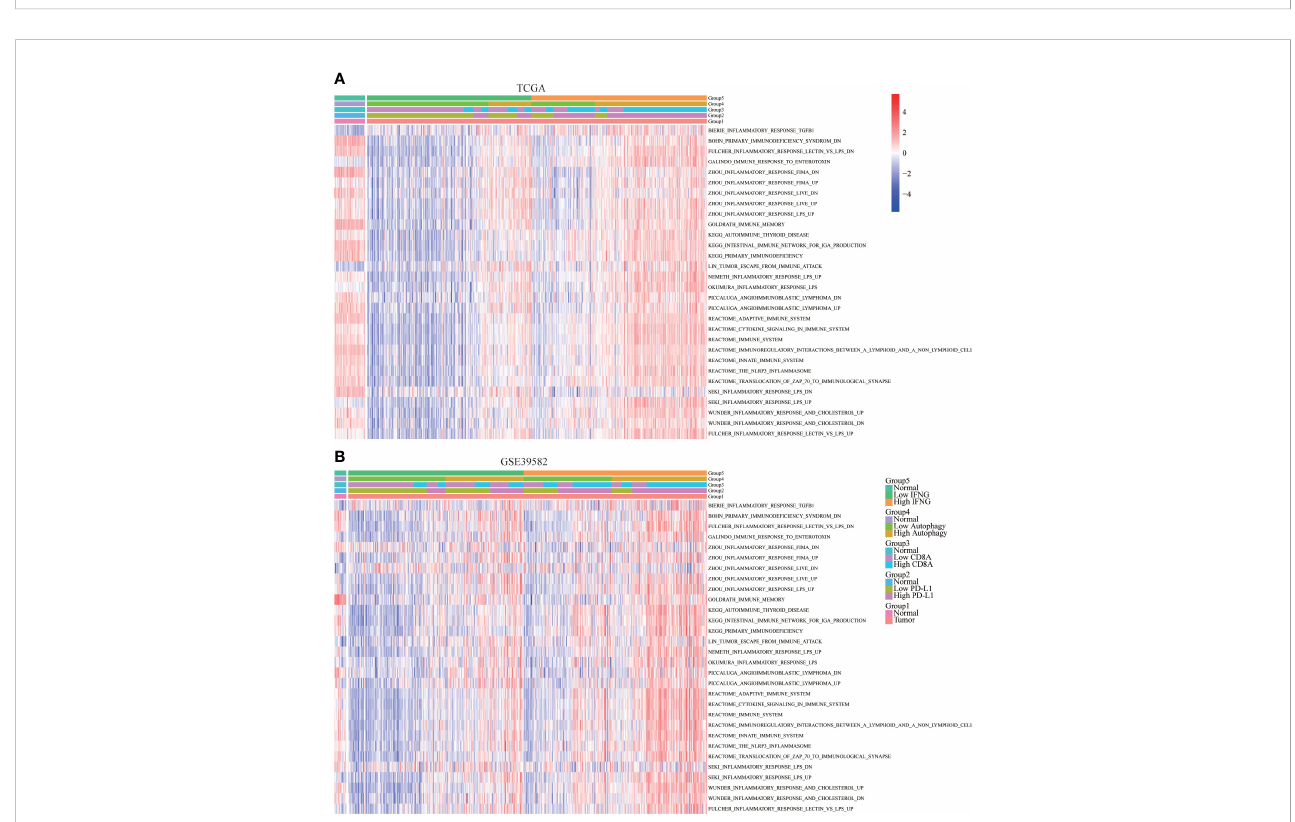
FIGURE 8 Correlation of immune-related pathways. In (A) TCGA and (B) GSE39582, the activity of most immune-related pathways in the high IFNG group and high autophagy score group were signi fi cantly